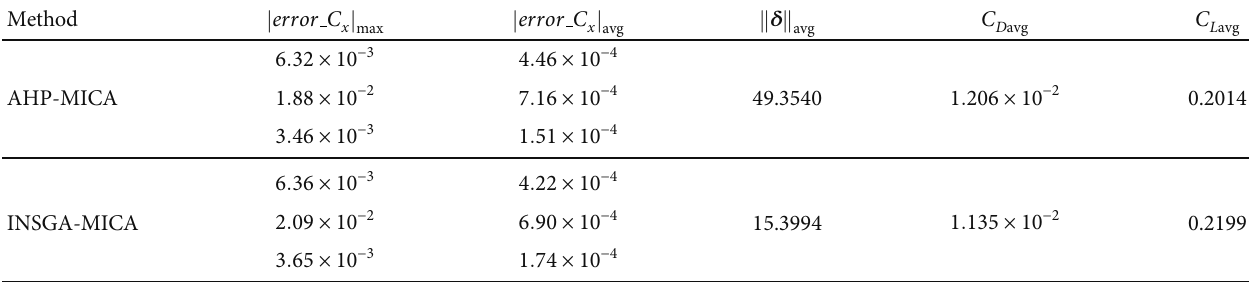
Table 5: Performance comparison of AHP-MICA and INSGA-MICA.